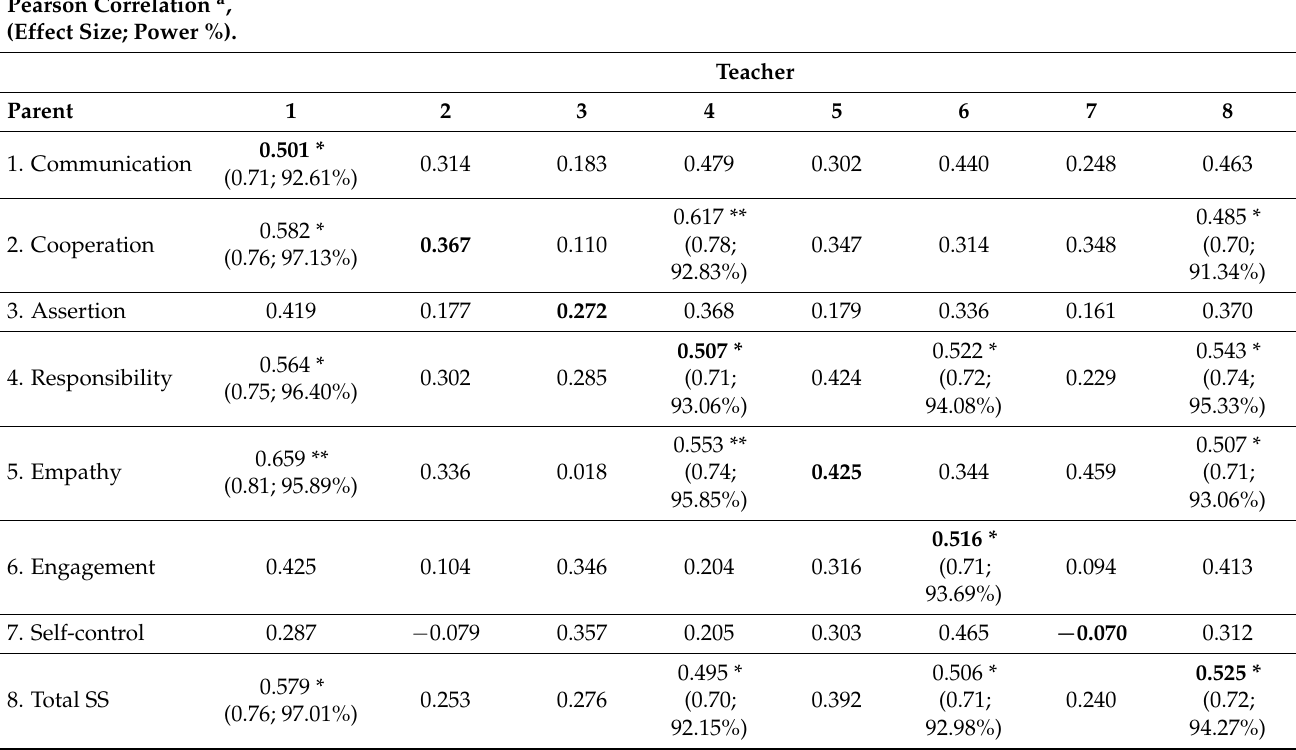
Table 3. Correlations for teacher–parent (subscales and total). Pearson Correlation a , (Effect Size; Power